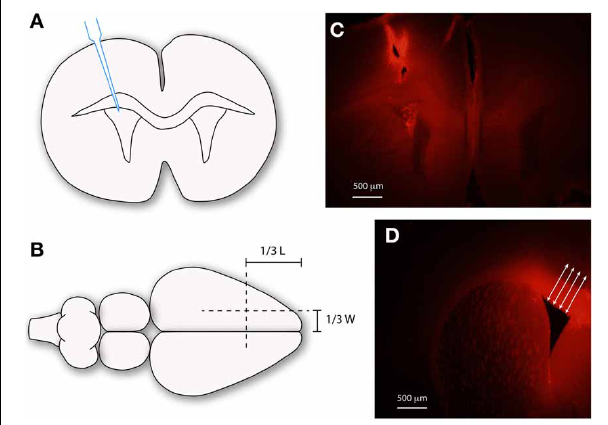
FIGURE 1 | Injection of biotin dextran amines into the ventricular system of mice. Schematic diagrams (A,B ) and images (C,D ) illustrating the methods used to inject dextrans into the lateral ventricles of mouse brain. (A) Micropipette injection of dextran into lateral ventricle. (B) Illustrates surface landmarks for injection site. (C) Distribution of dextran following injection. (D) Method used to measure diffusion distance of dextrans (red) using ImageJ64. Mean of 10 measurements, spanning the ventricular zone at right angles to ventricular surface (arrows). Scale bars 500 μ m in (C,D) . L, length; W, width.